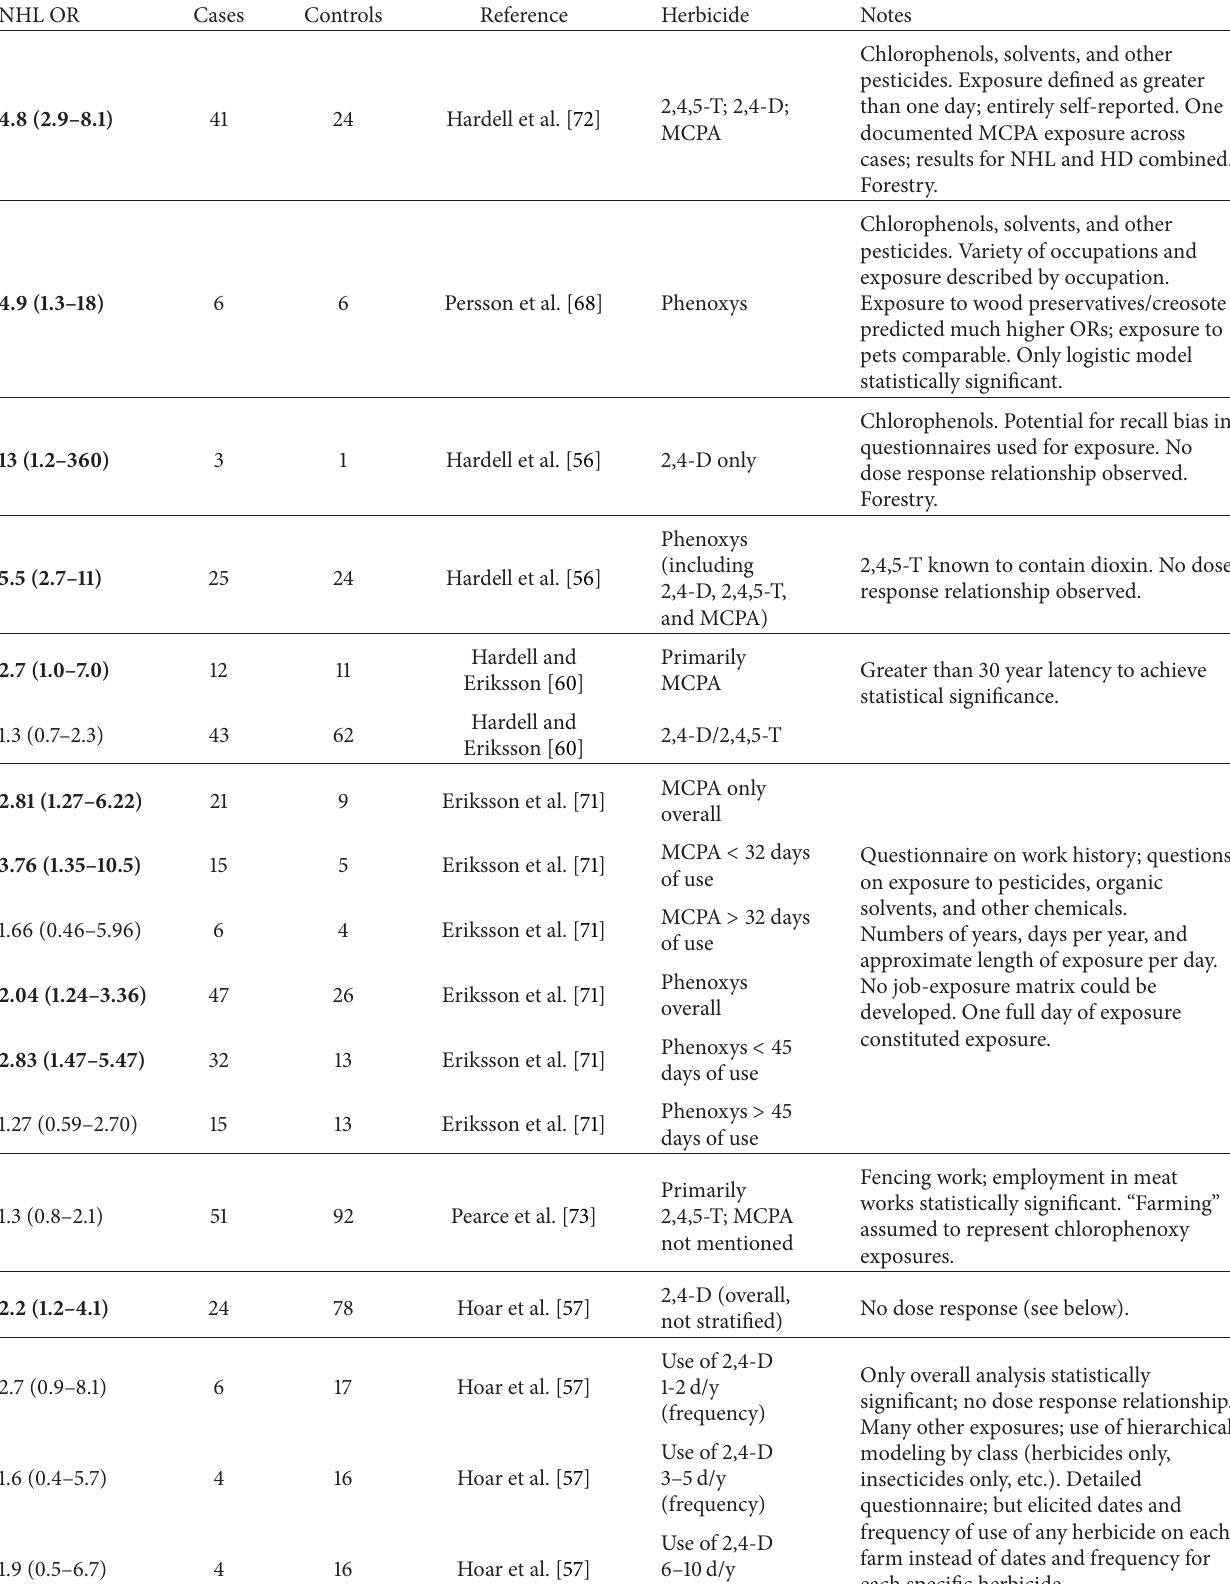
Table 2: Case-control studies of chlorophenoxy compounds and